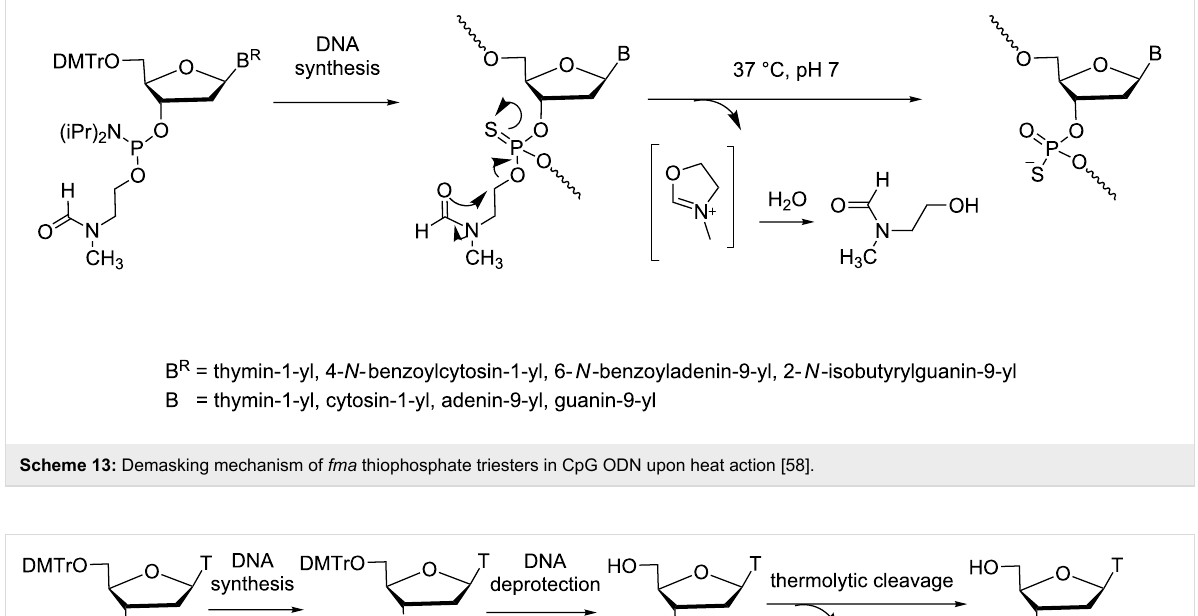
Scheme 13: Demasking mechanism of fma thiophosphate triesters in CpG ODN upon heat action [58].